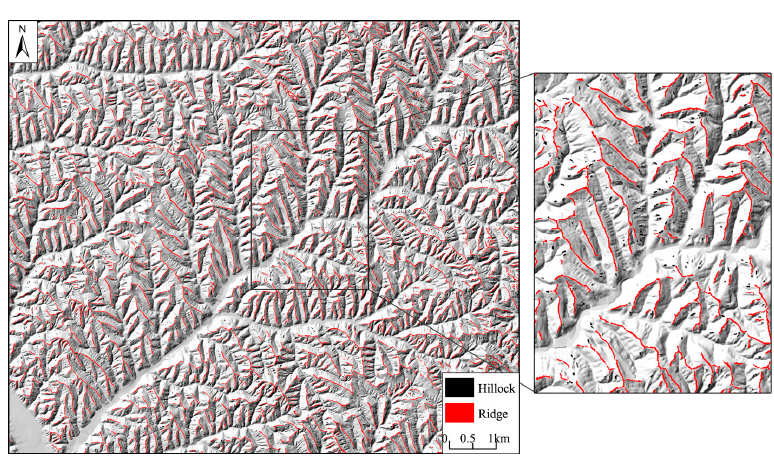
Figure 8. Classification of hillocks and ridges.